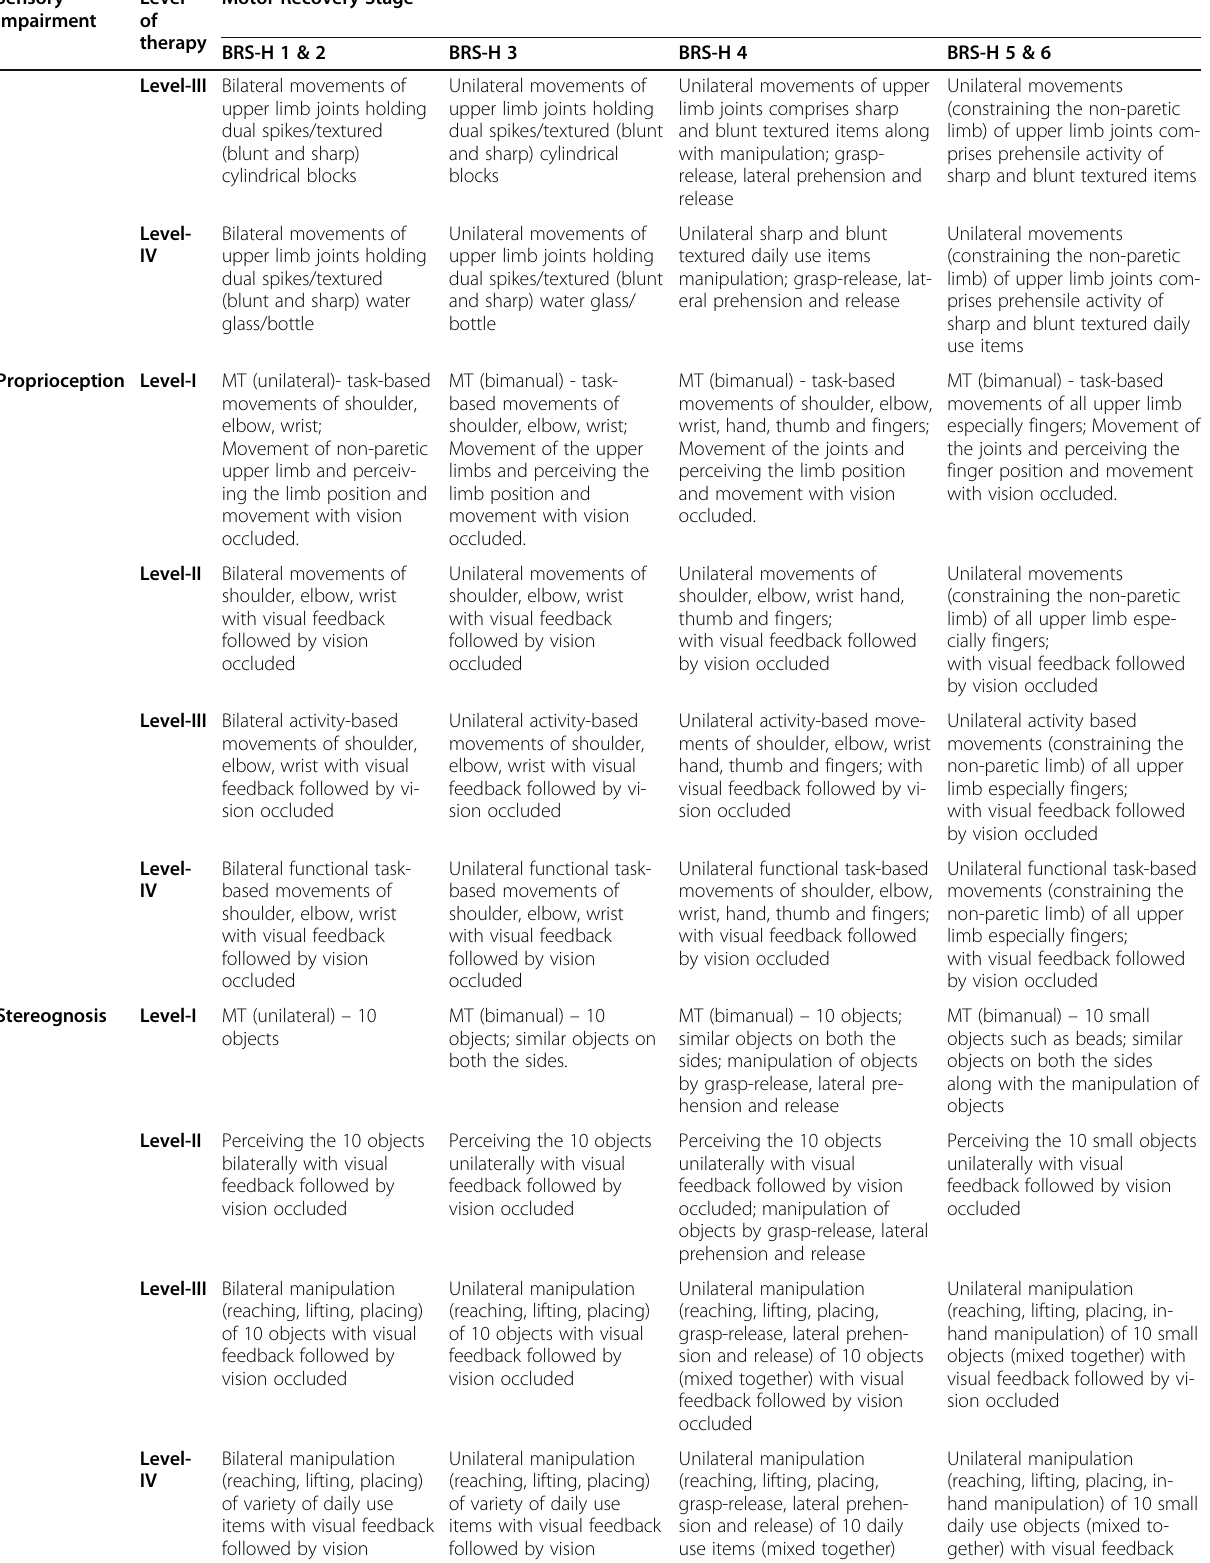
Table 1 Experimental intervention as per the type of sensory impairment and motor recovery stage of the hand